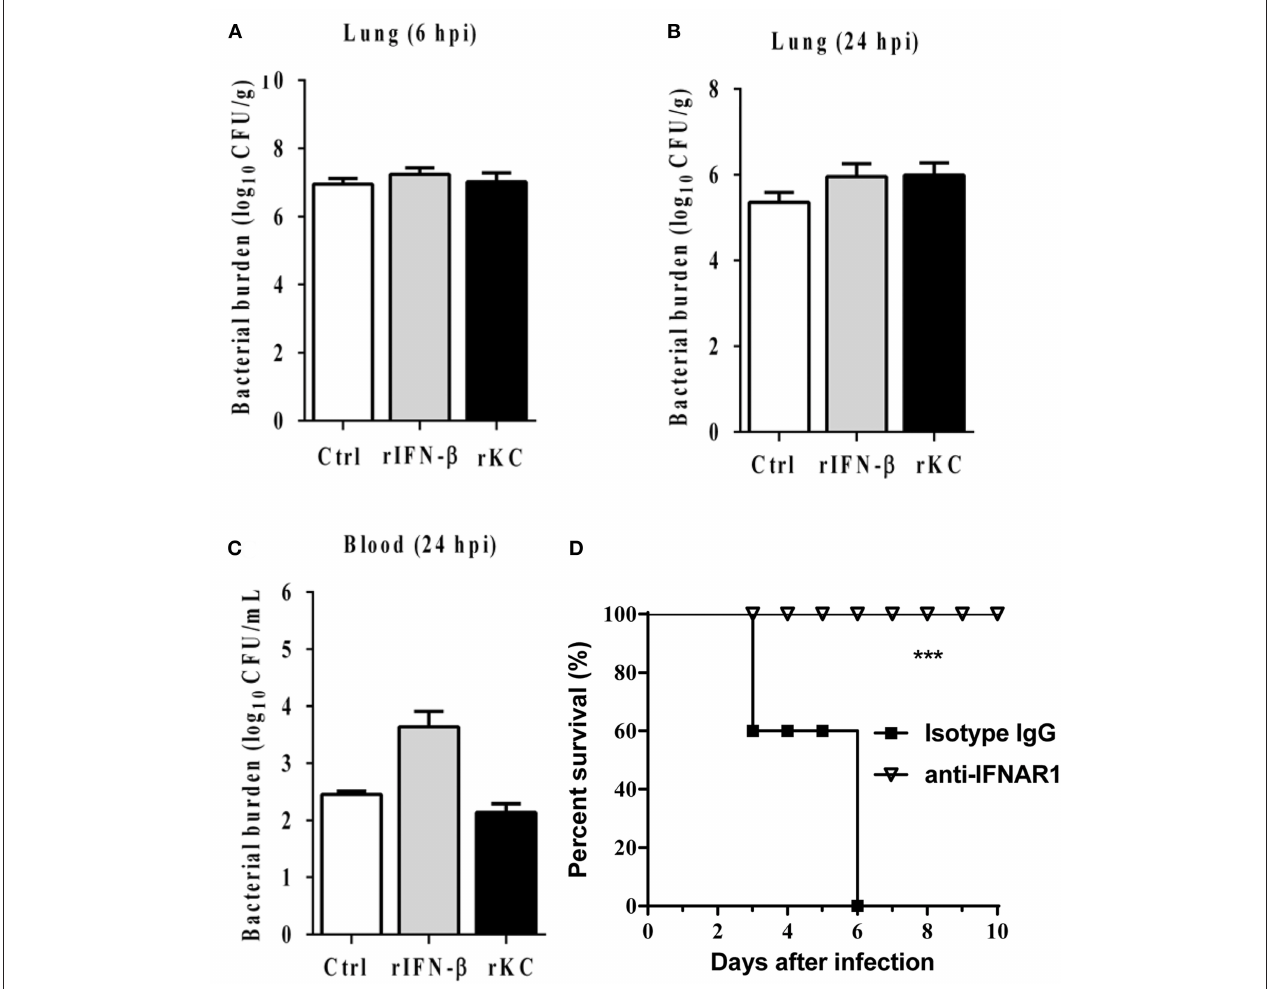
FIGURE 6 | IFN- β and KC are dispensable for IFI204-mediated host defense. IFI204 − / − mice were i.p. injected recombinant KC or IFN- β ( n = 10 each group) at a dose of 1.0 µ g per mouse in 100 µ L PBS on Day − 1 and Day 0. The mice were infected intranasally with 1 × 10 8 CFU of Staphylococcus on Day 0. (A,B) Homogenized lung tissues were subjected to plating serial dilution for bacterial loads at 6 hpi or 24 hpi. (C) Blood were subjected to plating serial dilution for bacterial loads at 24 hpi. All data are shown as mean ± SEM. Student’s t -test was performed. (D) The mice were i.p. injected with 2.5mg anti-mouse IFNAR1 neutralizing mAb or 2.5mg IgG isotype control ( n = 8 each group), 24h later, mice were i.v. challenged with 2 × 10 8 CFU of Staphylococcus . The animals were monitored daily for survival. *** p < 0.005.